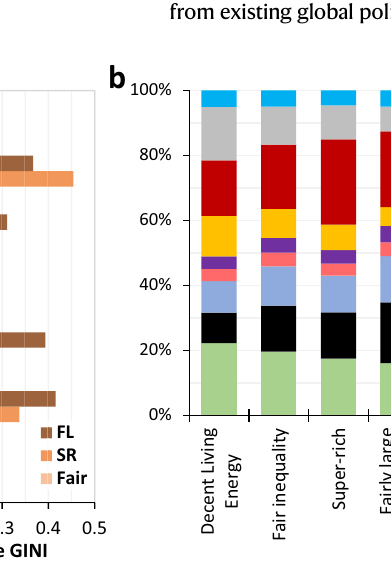
inequality scenarios, alongside the DLE scenario. Note, some of the legend is abbreviated: FL Fairly Large Inequality, SR Super-rich and Power infra ’ =Power infrastructure (i.e. the energy use involved in constructing power supply infrastructure).